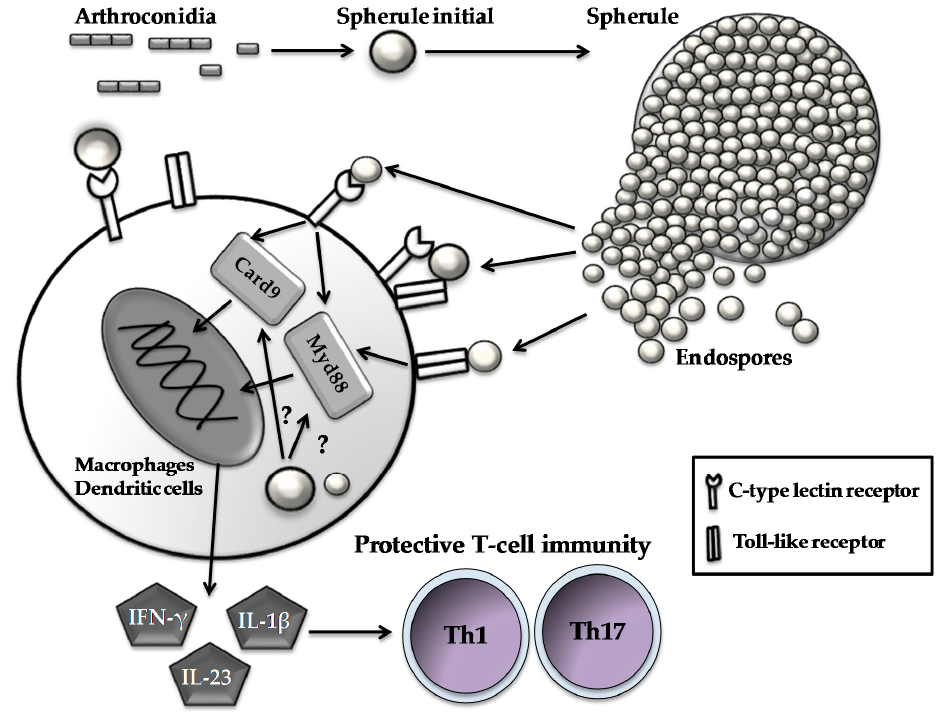
Figure 1. Host immune cells respond to parasitic cells of Coccidioides . Spherules and endospores are recognized by C-type lectin receptors and Toll-like receptors expressed on innate cell types to initiate a signal cascade via activating intracellular immune adaptors (i.e., Card9 and Myd88). Subsequently, the activated innate cells produce pro-inflammatory cytokines such as interferon- γ (FN- γ ), interleukin (IL)-23 and IL-1 β , which, in turn, guide the development and differentiation of Th1 and Th17 cells.